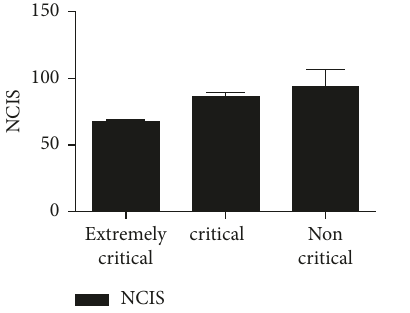
Figure 3: Comparison of NCIS scores in children with RDS of different severity.